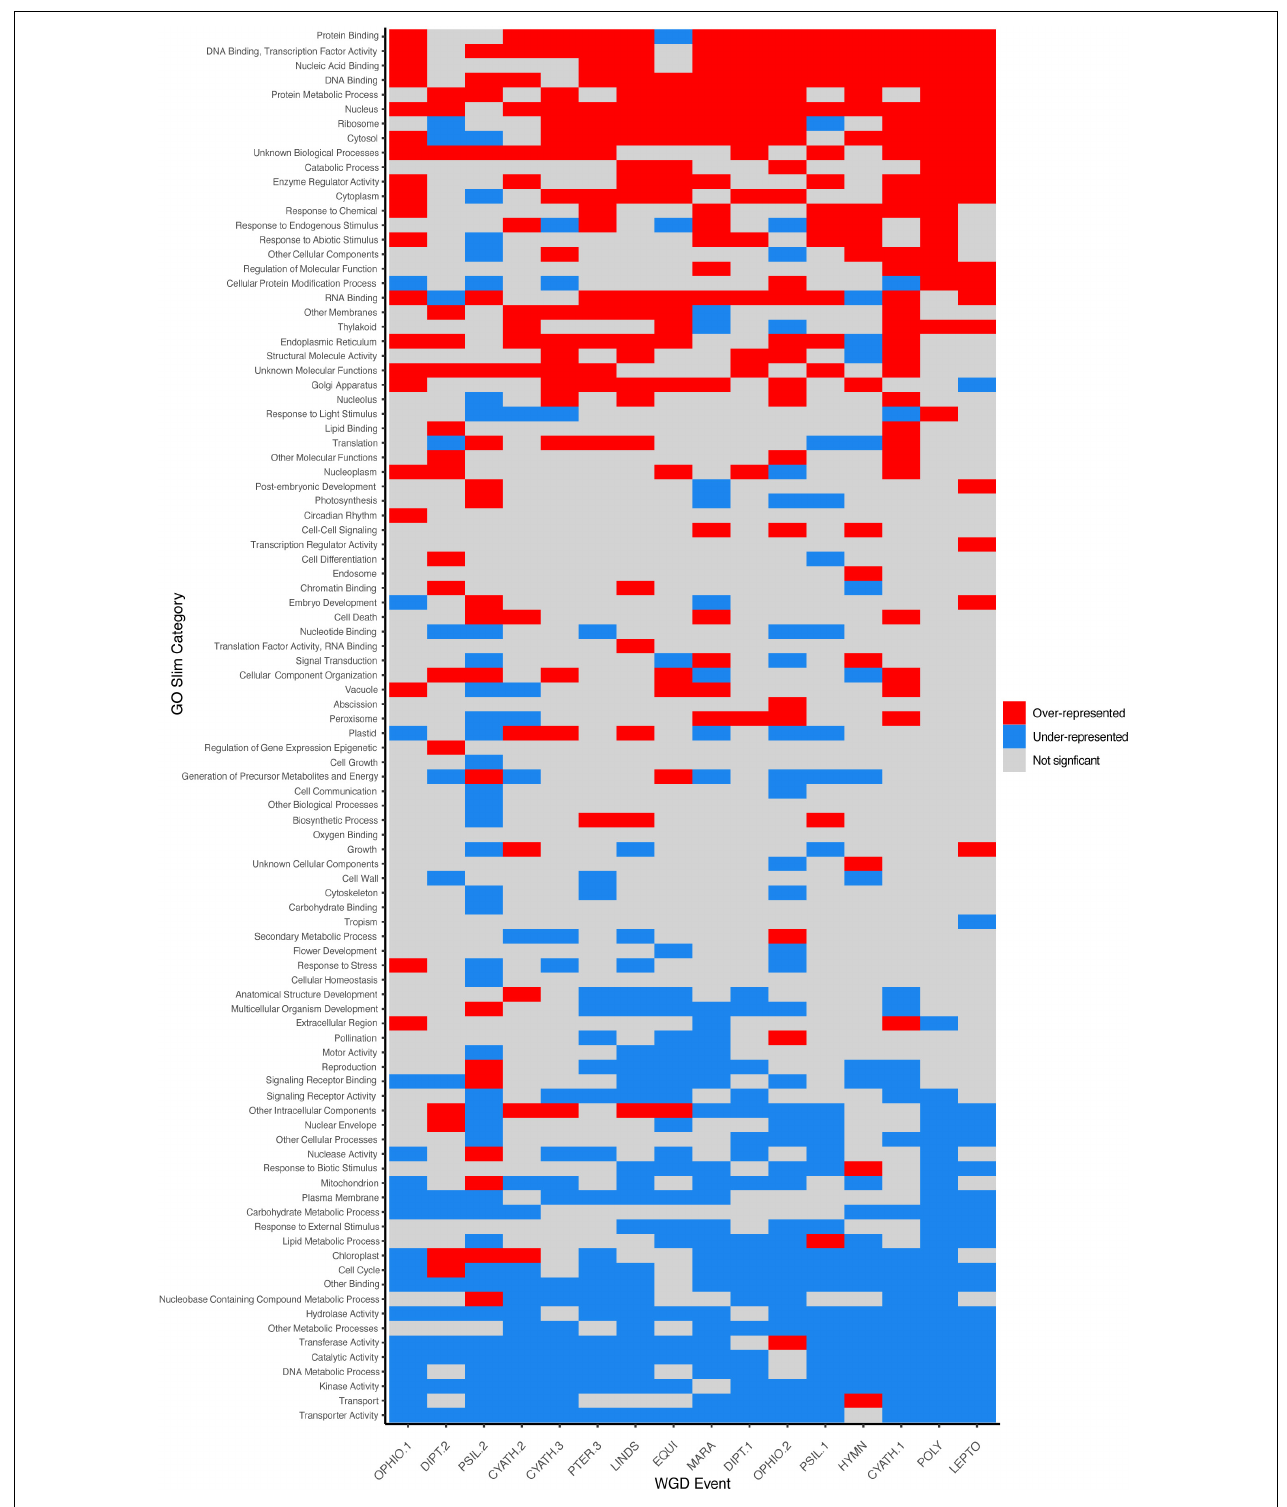
FIGURE 5 | Gene retention in ferns following large-scale duplications is biased. Gene ontology (GO) Slim composition of retained duplicates (paralogs) from 17 of the 18 large-scale whole genome duplications (WGDs) identified in this study are shown, where categories that are over-represented in paralogs are in red (Chi-squared residuals > 2) and under-presented as blue (Chi-squared residuals < -2). Terms with non-significant residuals are gray. Events are sorted by ascending median Ks values. Note that SALV is not shown here; while MAPS identified a significant proportion of duplicated gene trees, uncorrected K S plots were ambiguous, although a WGD was identified with syntenic analyses in Li F. W. et al. (2018).